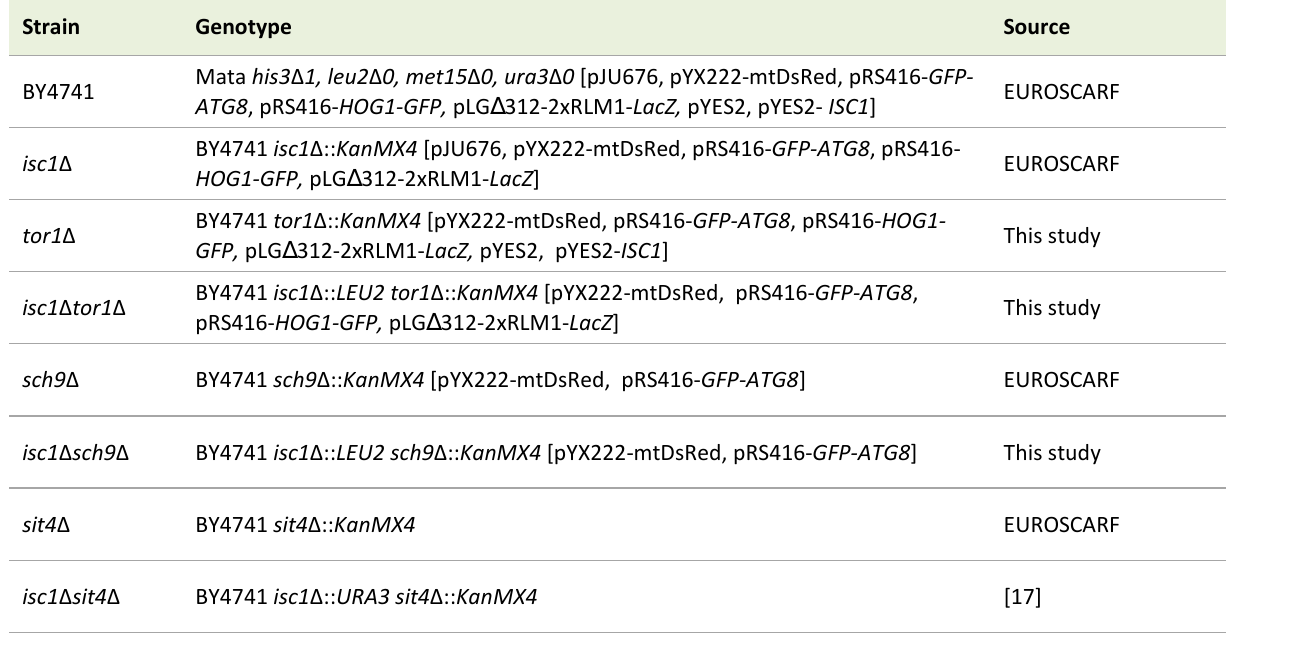
TABLE 1. Saccharomyces cerevisiae strains used in this study. Harboring plasmids are shown in square